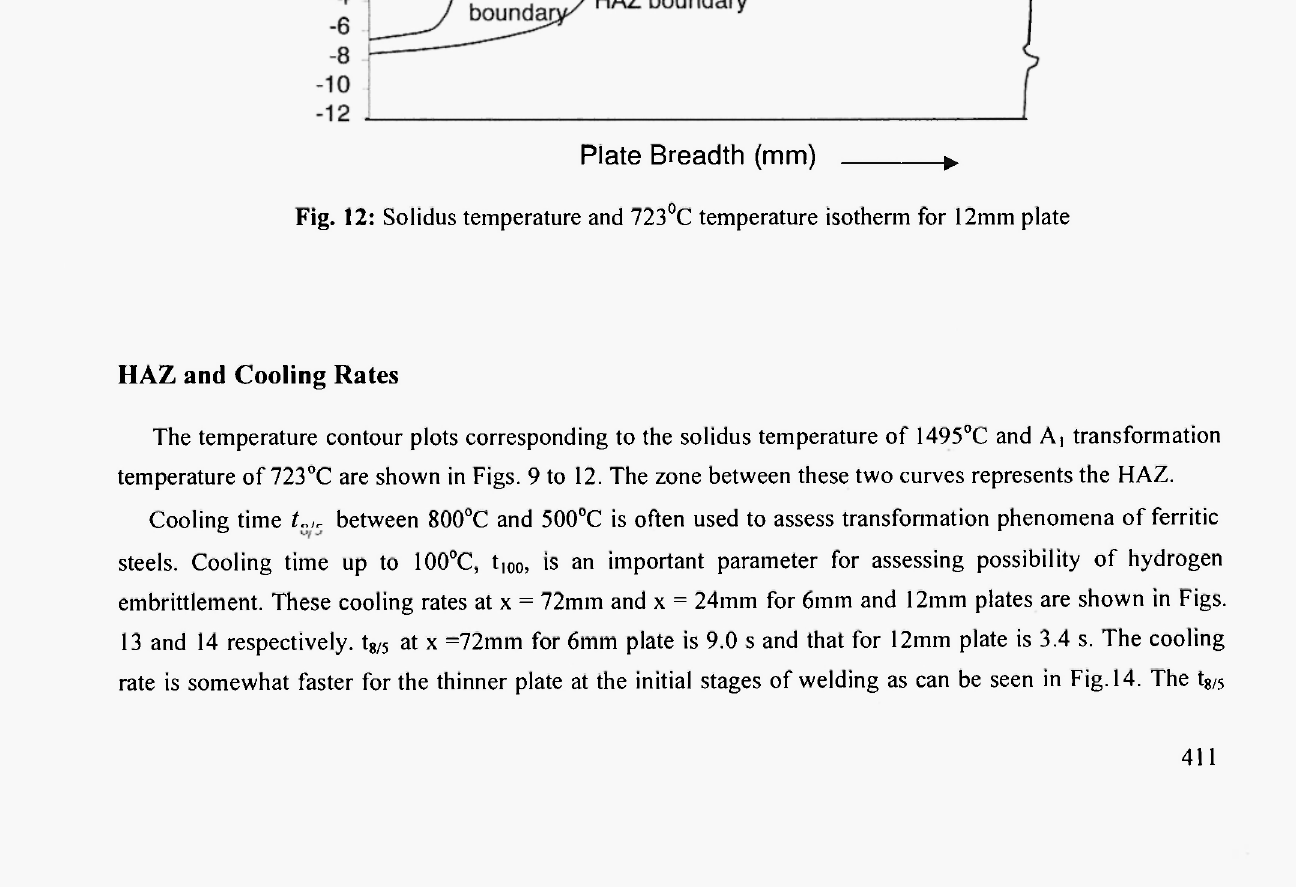
Fig. 12: Solidus temperature and 723°C temperature isotherm for 12mm